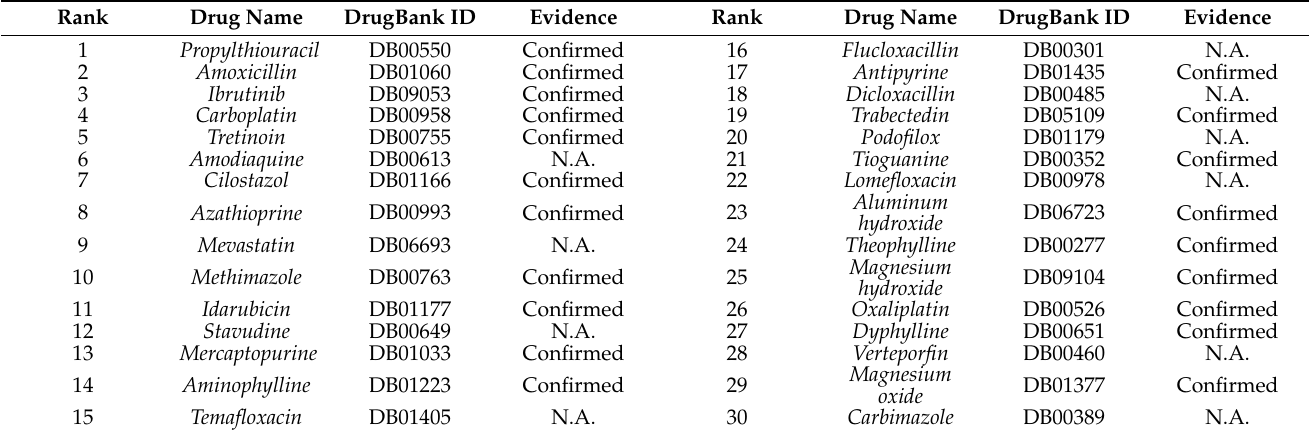
Table 7. The top 30 interactions of Allopurinol